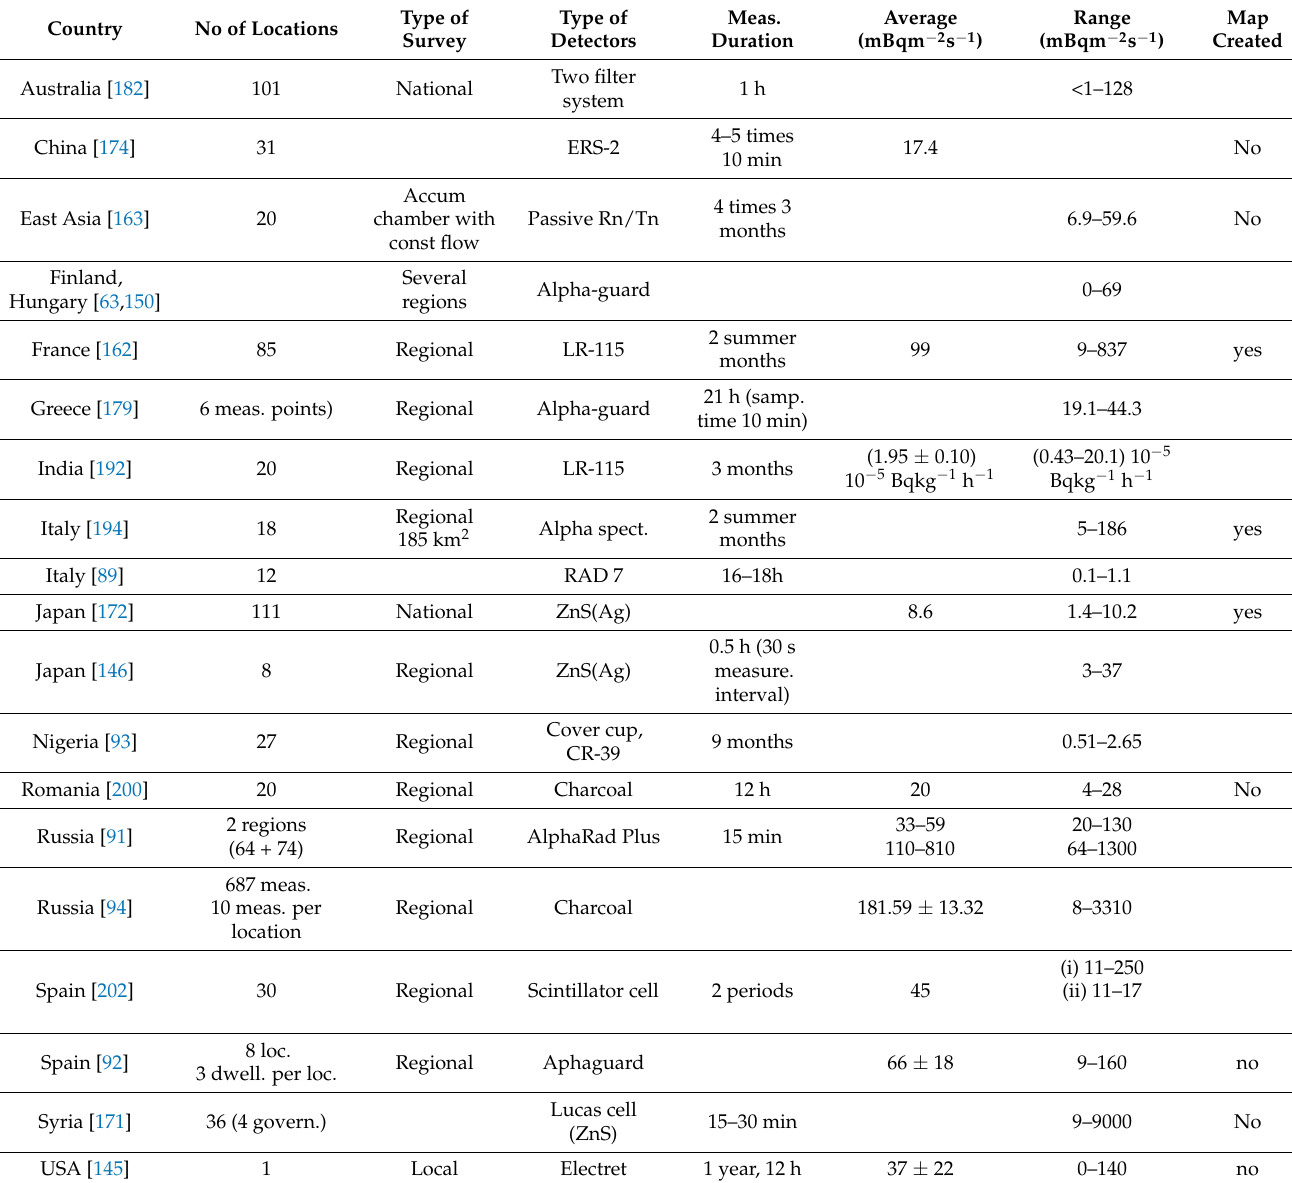
Table 1. Overview of radon flux surveys performed in some